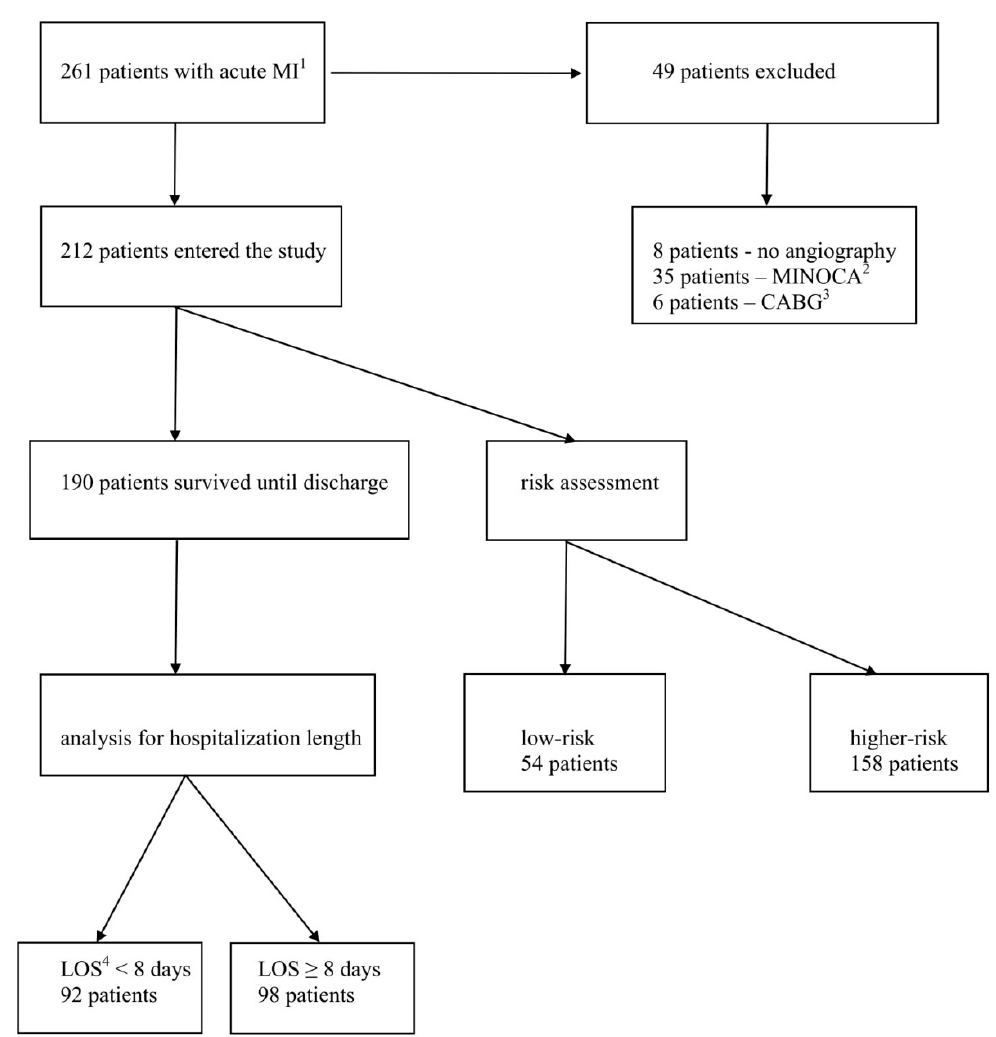
Figure 1. Flow chart of patients entering the study. 1 myocardial infarction; 2 myocardial infarction without obstructive coronary arteries; 3 coronary-artery bypass grafting; 4 length of hospital stay.